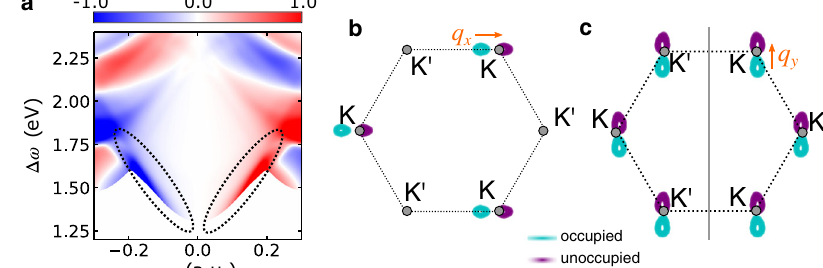
Fig. 3 Circular dichroism in RIXS from MoSe 2 . a Normalized circular dichroism of the RIXS cross-section ( I LCP − I RCP )/( I LCP + I RCP ) of monolayer MoSe 2 . I LCP ( I RCP ) denotes the RIXS intensity for left-circular (right-circular) polarization. The incoming photon energy ω i and the geometry is the same as in Fig. 2d. The ellipses indicate the region where the OAM of the top valence band dominates the signal. b Sketch of the phase space of the d - d excitations permitted by energy and momentum conservation at fi xed momentum transfer q x = 0.164 a.u. and energy loss Δ ω = 1.73 eV. The scattering plane is spanned by the x and the z direction. c Analogous sketch for momentum transfer q direction. The vertical gray line indicates the mirror plane.